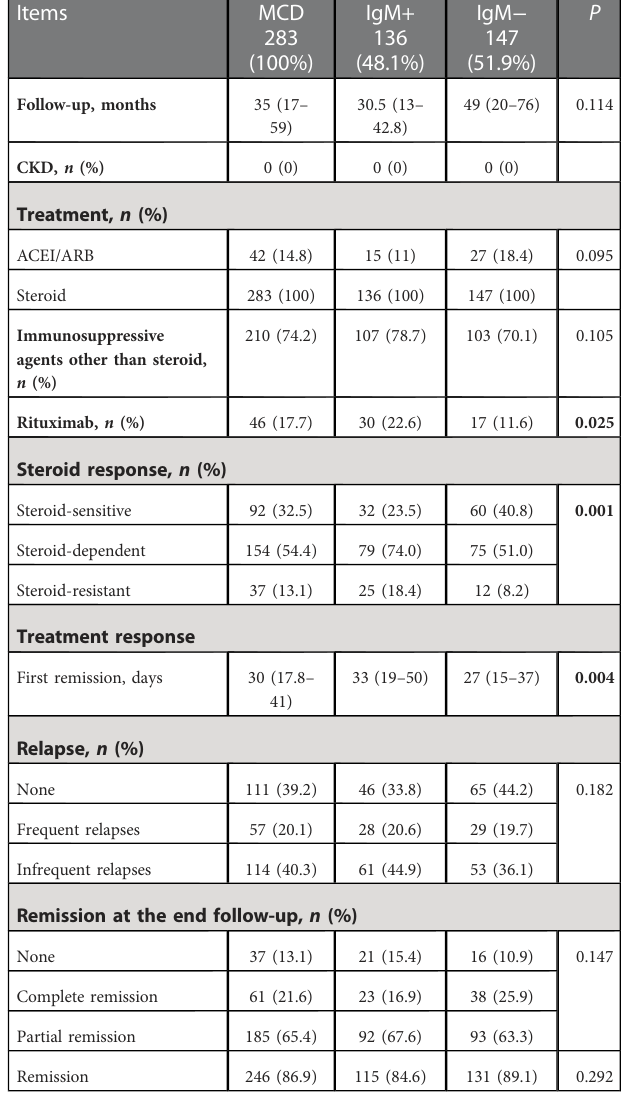
P values less than 0.05 are highlighted in